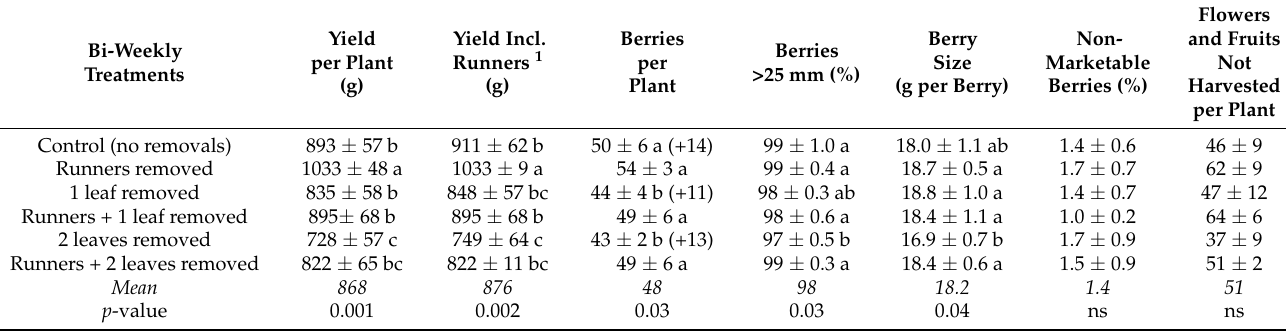
Table 1. Effects of bi-weekly runner removal and leaf thinning in the period 5 June to 25 September on yield performance (berries harvested from 5 July to 7 October) of the everbearing strawberry cv. ‘Favori’. The data are means ( ± SD) of three replicates with six plants each.